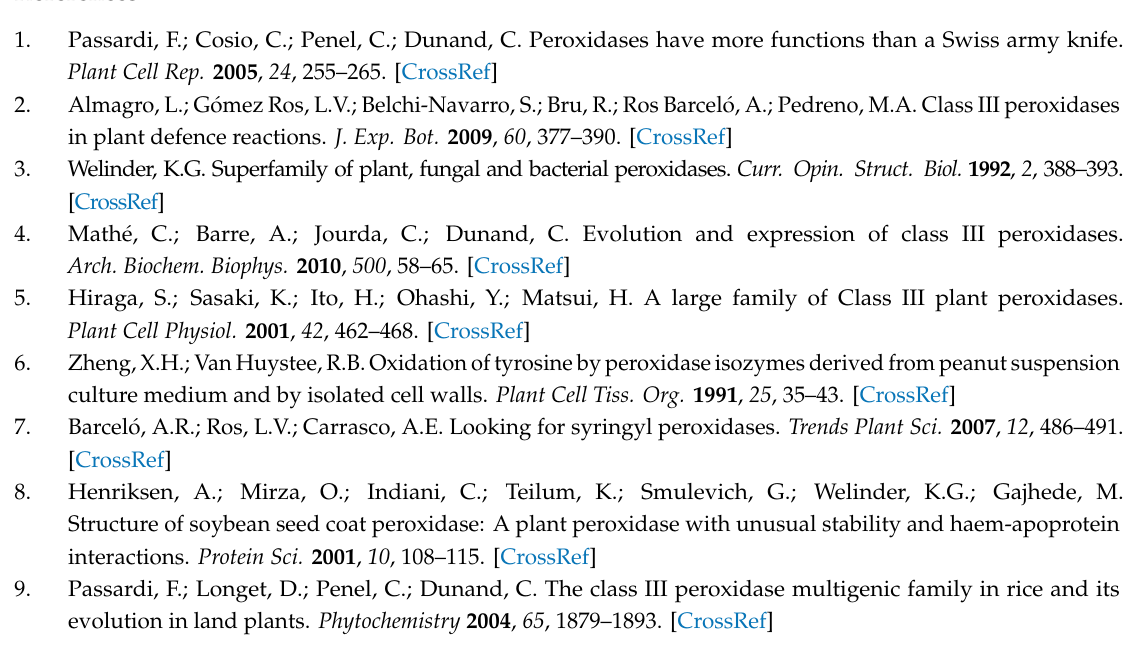
s1. Table S1. Characteristics of PODs in cassava. Table S2. The Ka / Ks ratios of duplicated POD genes in cassava. Table S3. The expression profiles (log2-based values) of the cassava POD genes in di ff erent tissues. Table S4. The expression profiles (log2-based fold changes) of the cassava POD genes after drought treatment. Table S5. The expression profiles (log2-based fold changes) of the cassava POD genes after harvest. Table S6. The expression profiles (log2-based values) of the cassava POD genes after various stress treatments. Table S7. Primers used in qRT-PCR analysis. Figure S1. Phylogenetic analyses of 91 MePODs, 2 AtPRXs, 3 OsPRXs, and 3 ZmPRXs. Author Contributions: W.H., X.D., and H.Y. designed the research; C.W., X.D., Z.D., and Y.Y. performed the research; X.D., W.T., C.W., and Y.W. analyzed the data; X.D. and C.W. wrote the paper; W.H., Z.D., and